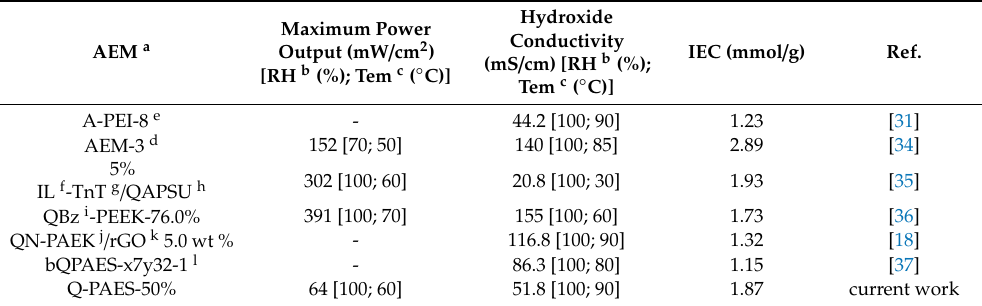
Figure 10. ( a ) Single fuel cell operation curve and ( b ) durability plot of Q-PAES-50% quantified at 60 ◦ C and 100% RH. (Catalyst of anode and cathode was Pt / C, 0.3 mg / cm 2 ; humidified hydrogen (100 mL) and oxygen (300 mL) were passed to anode and cathode). Table 2. Comparison table of Q-PAES-50% with other reported